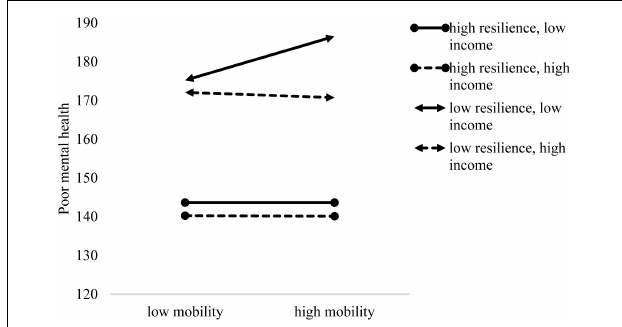
FIGURE 1 | The interaction effect of resilience, family income, and residential mobility in adolescence in predicting university students’ mental health.